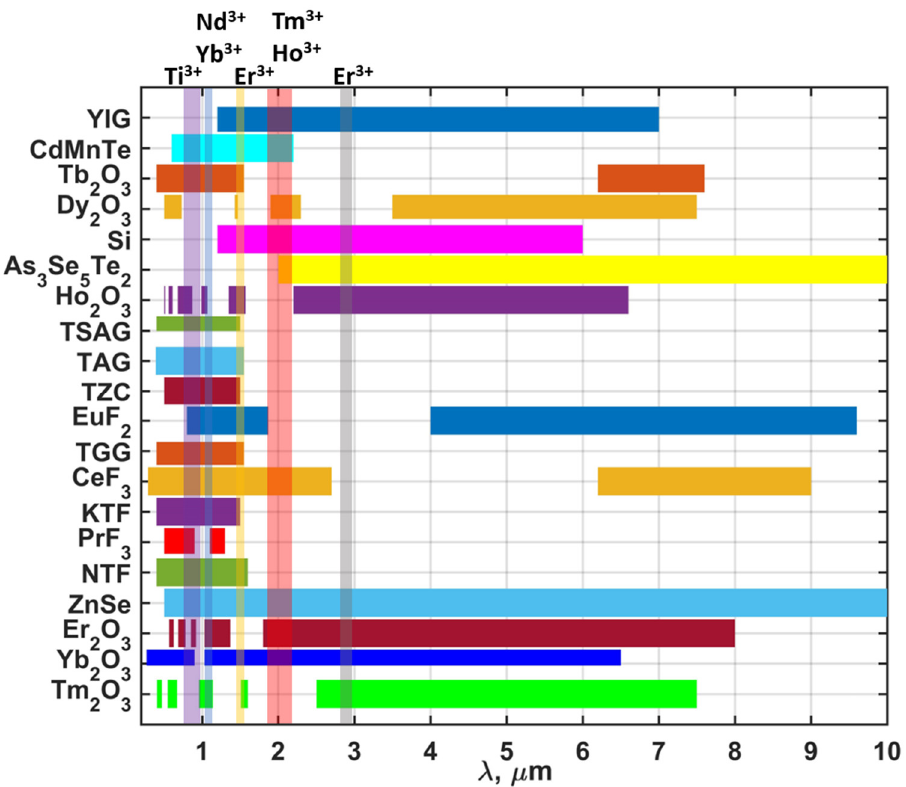
Figure 1. Transmission spectra of magneto-optical materials. Arranged in descending order of the Verdet constant value from top to bottom. Translucent vertical stripes indicate the characteristic spectral regions in which lasers based on the specified above ion can generate radiation.